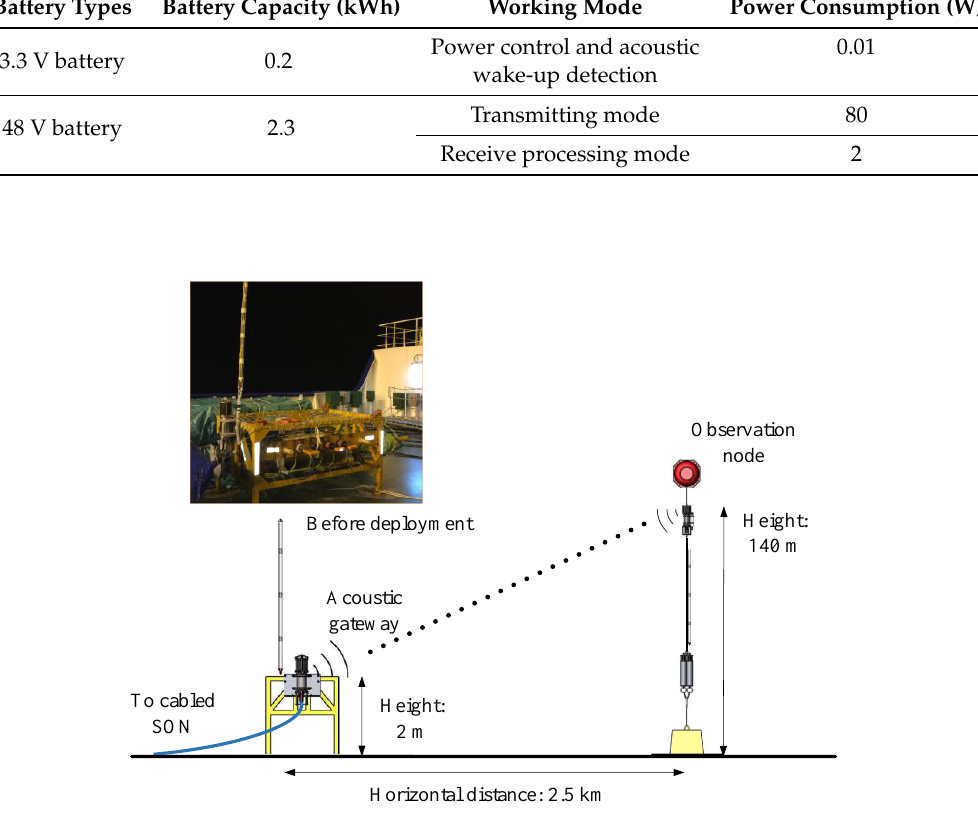
Figure 10. Demonstration of communication nodes in the SON experiment.